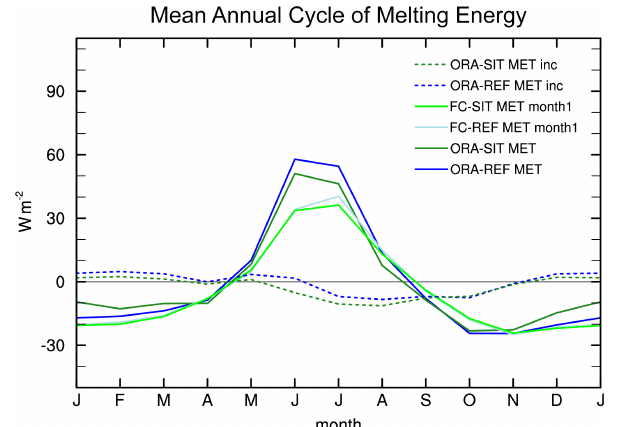
Figure 9. Mean annual cycle of MET over the ocean area north of 70 ◦ N in ORA-REF, ORA-SIT, FC-REF (lead month 1) and FC-SIT (lead month 1). MET increments for ORA-REF and ORA-SIT are shown as